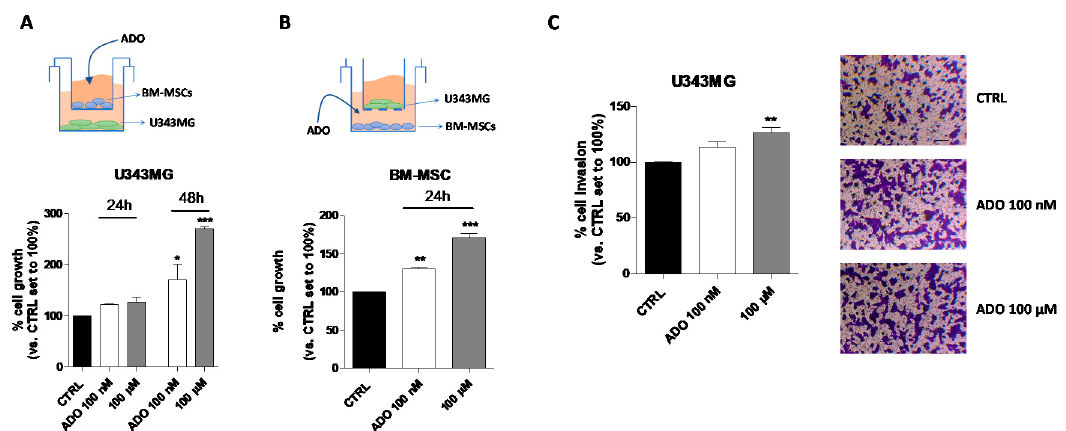
Figure 6. E ff ects of ADO in the BM-MSC and GBM cell cross-talk. ( A ) The image depicts the contact-independent transwell cultures with BM-MSCs in the upper chamber and U343MG in the lower chamber. U343MG cell proliferation was evaluated after 24 and 48 h with Crystal violet, as reported in Section 4.9. ( B ) The image depicts the contact-independent transwell cultures with U343MG in the upper chamber and BM-MSCs in the lower chamber. BM-MSCs cell proliferation was evaluated after 48 h with Crystal violet, as reported in Section 4.9. ( C ) U343MG cells were seeded in the upper chamber and BM-MSCs treated with ADO (100 nM and 100 µ M) in the lower chamber. After 24 h, U343MG cell invasion was analyzed using Matrigel basement membrane transwell system, as described in Section 4.10. Representative images are shown. Cell migration was quantified by counting the number of cells that migrated into the lower surface of the transwell membrane. The data are reported as percentage of cell invasion versus the CTRL set to 100% and are the means ± SEM of three independent experiments. The significance of the di ff erences was determined by one-way ANOVA, followed by Bonferroni’s post-hoc test. * p < 0.05, ** p < 0.01, *** p < 0.001 vs. CTRL.